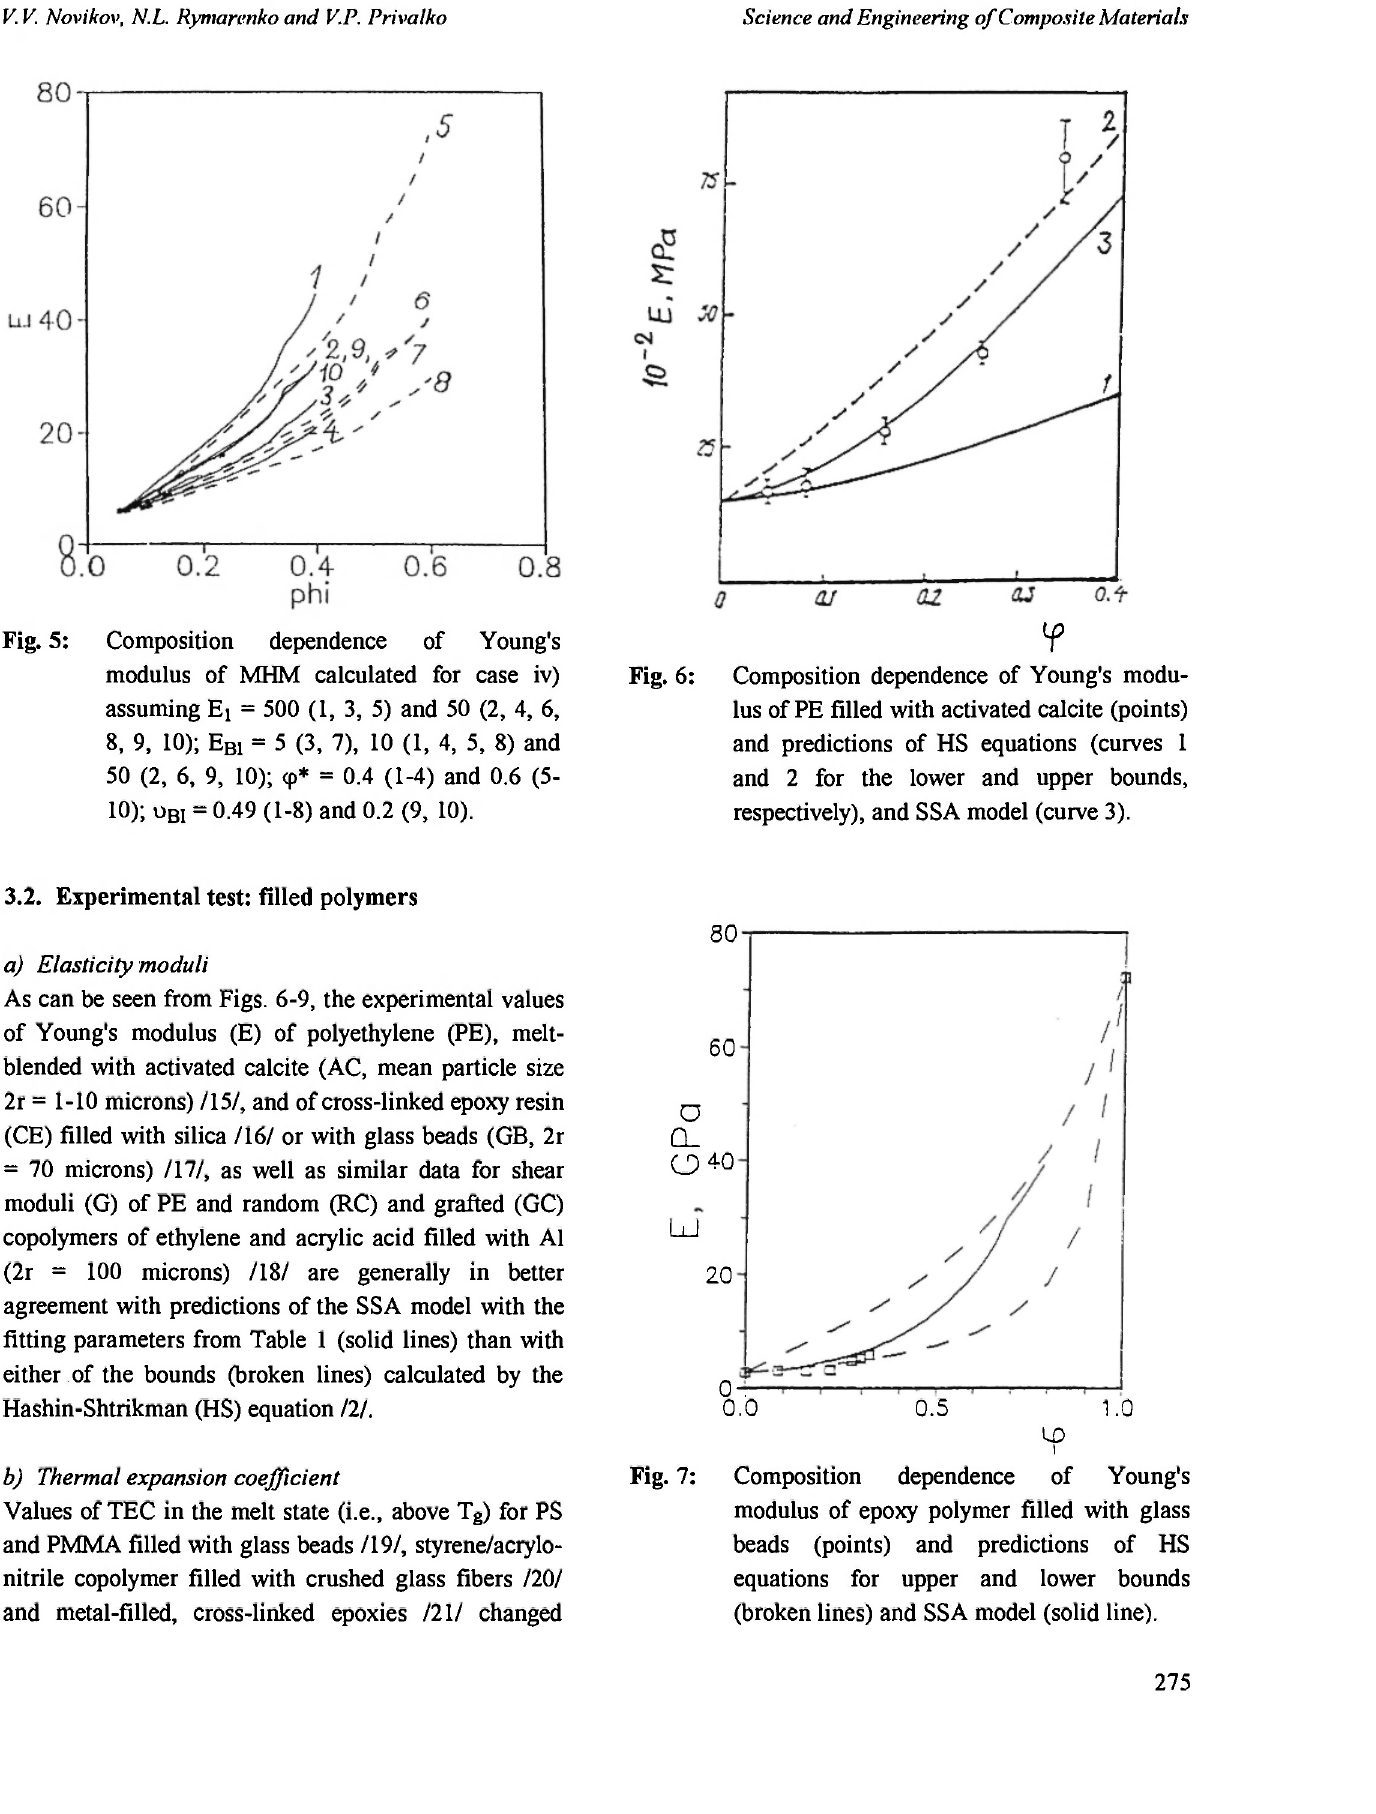
Fig. 5: Composition dependence of Young's modulus of MHM calculated for case iv) assuming Ei = 500 (1, 3, 5) and 50 (2, 4, 6, 8, 9, 10); Ebi = 5 (3, 7), 10 (1, 4, 5, 8) and 50 (2, 6, 9, 10); φ* = 0.4 (1-4) and 0.6 (5- 10); υ ΒΙ = 0.49 (1-8) and 0.2 (9, 10).